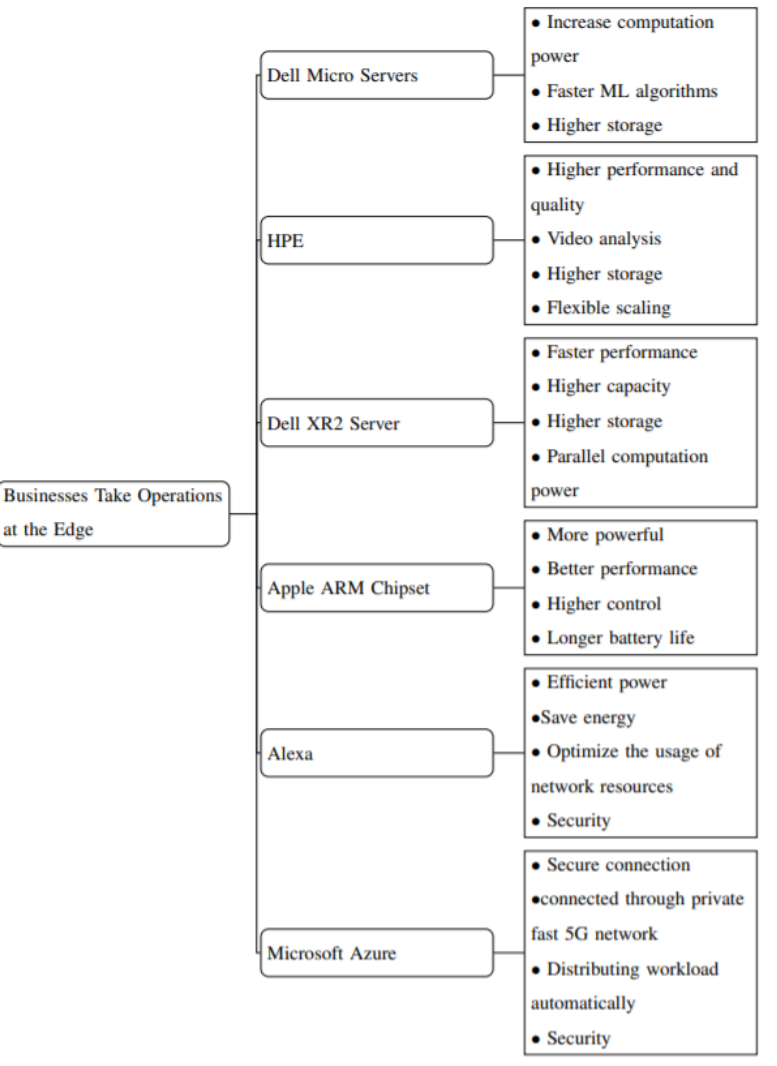
Figure 4. Businesses taking operations at the edge: Amazon, Apple, Dell, Hewlett Packard, Mi- crosoft